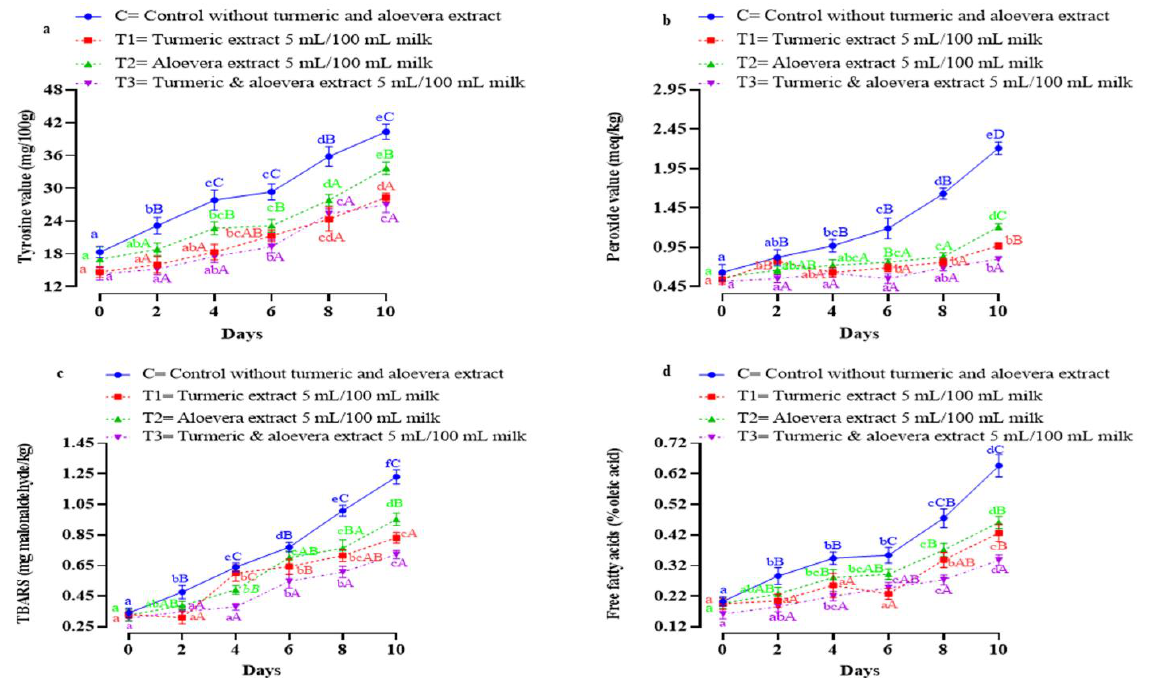
Figure 2. ( a – d ): Effect of turmeric and aloe vera extracts on tyrosine value and lipid oxidation attributes of goat and buffalo paneer during refrigerated aerobic storage. Means bearing different superscripts with small letters a, b, c, d and subscripts with capital letters A, B, C, D along a row and column, respectively, differ significantly at ( p < 0.05). C: Control paneer without turmeric and aloe vera extracts, T1: Paneer with turmeric extract (5 mL/100 mL) v / v of milk; T2: Paneer with aloe vera extract (5 mL/100 mL) v / v of milk; T3: paneer with turmeric extract (5 mL/100 mL) v / v of milk and aloe vera extract (5 mL/100 mL) v / v of milk.